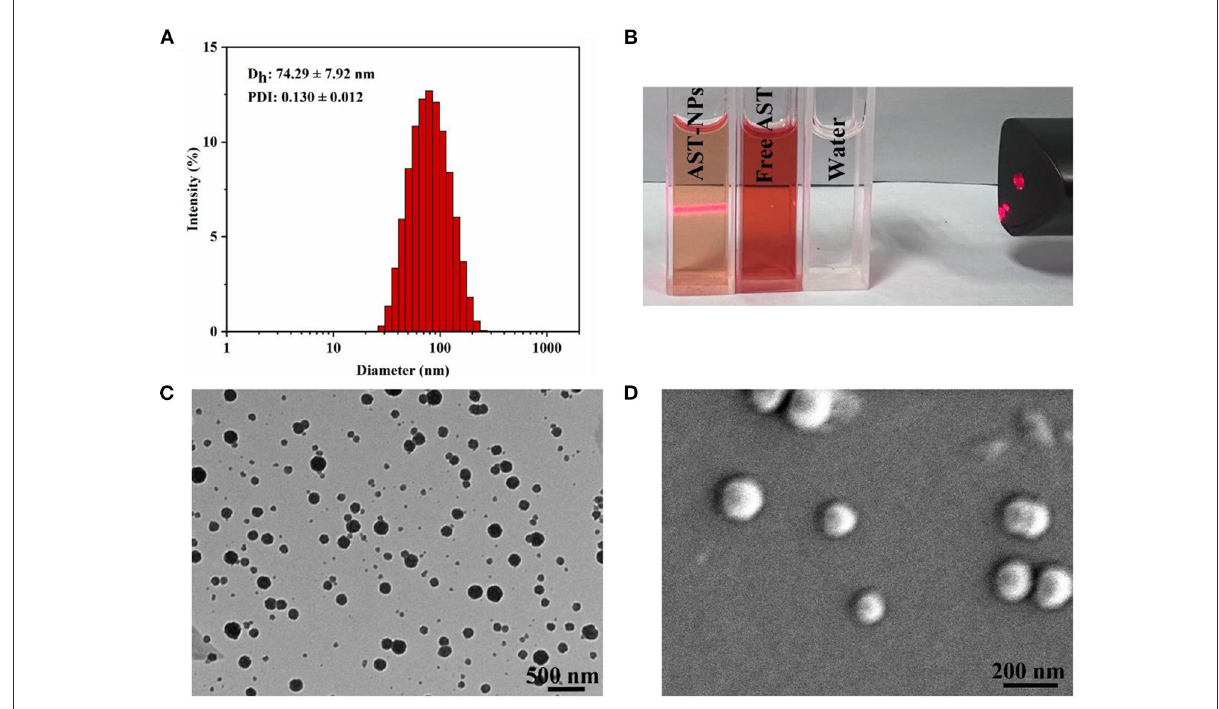
FIGURE2 (A) Particle size and PDI of AST-NPs. (B) Tyndall effect of AST-NPs. (C) TEM image and (D) SEM image of AST-NPs.